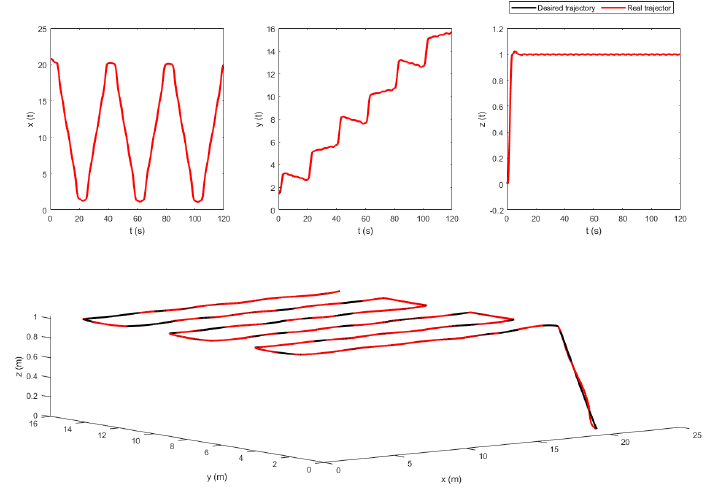
Figure 14. The tracking results of the flight in terrain 1.